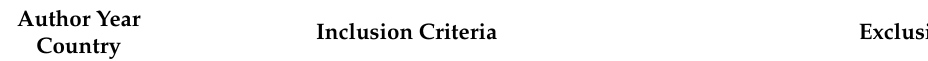
Table 2. Inclusion and exclusion criteria used in the included